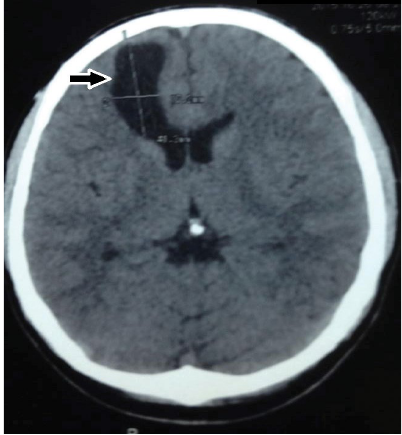
Figure 1: CT scan of head showing porencephalic cyst of right frontal lobe (indicated by arrow) that communicated with frontal horn of right lateral